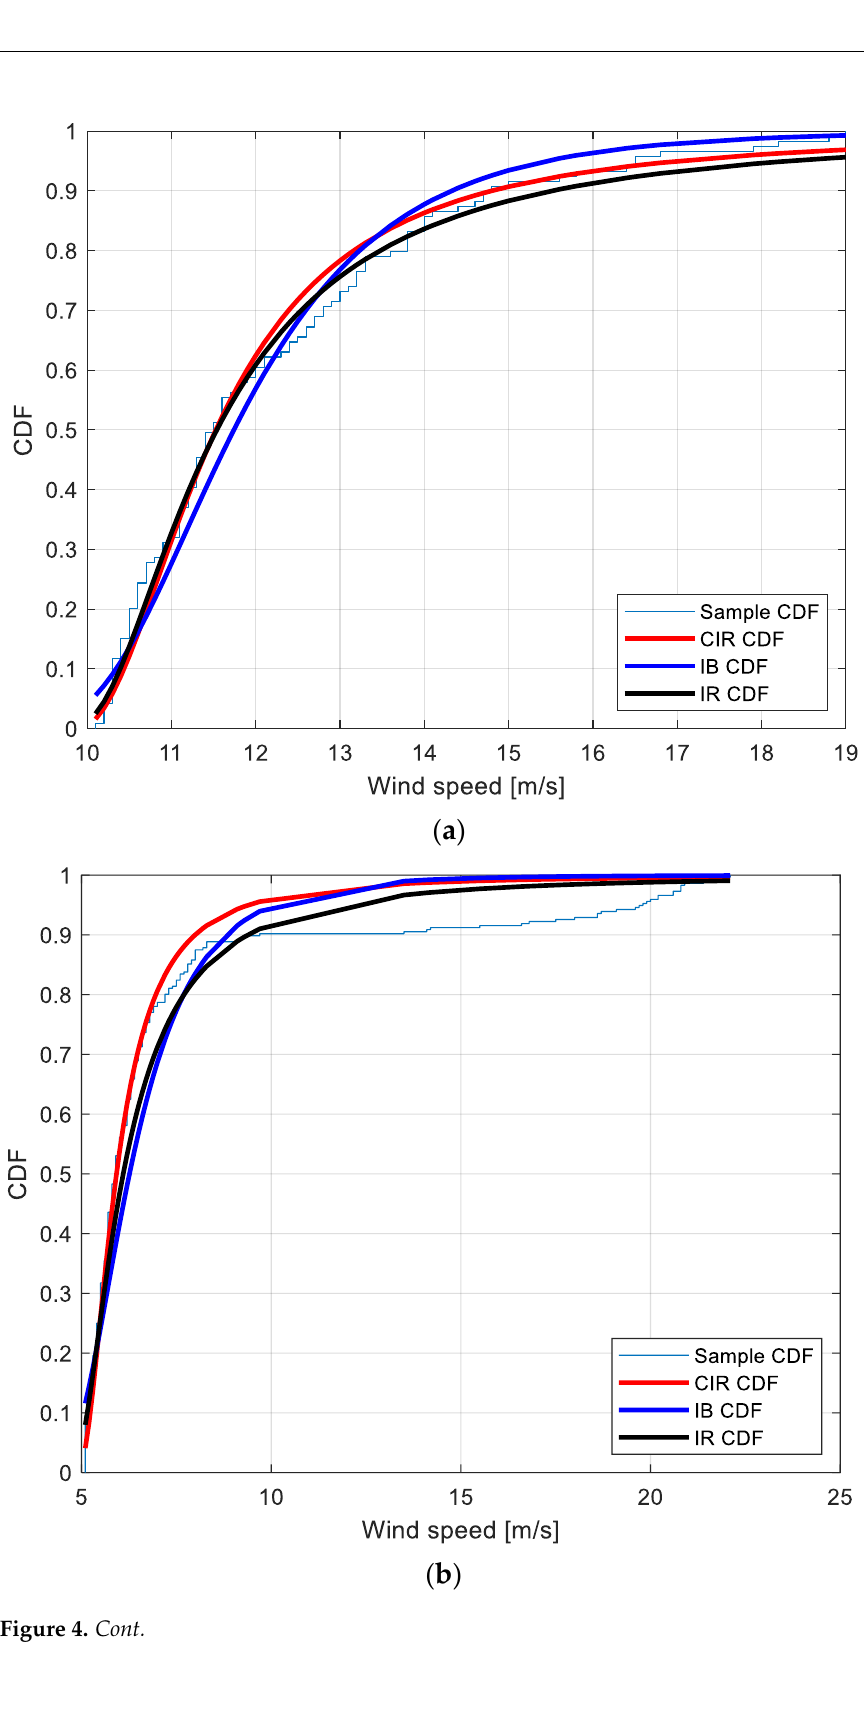
Figure 3. Sample CDF and fitted CIR, IB and IR distributions for the PM EWS at the locations: ( a ):